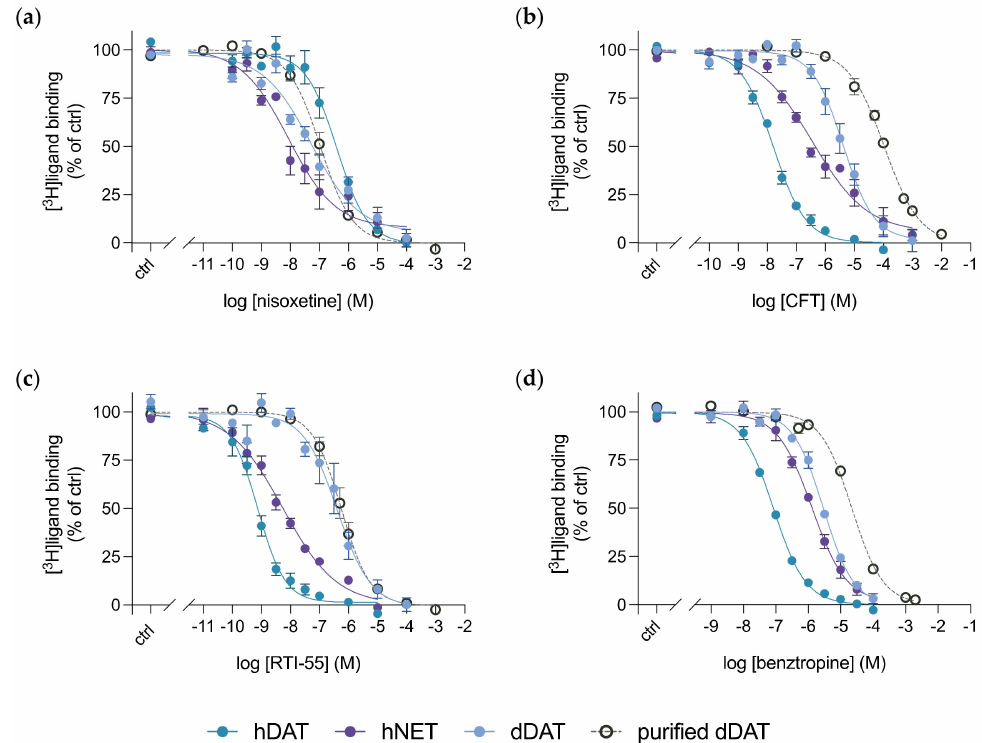
Figure 5. Competitive inhibition of radioligand binding to monoamine transporters in COS-7 cells or purified dDAT by ( a ) nisoxetine, ( b ) CFT, ( c ) RTI-55 and ( d ) benztropine. dDAT (blue filled circles), hDAT (green filled circles) and hNET (purple filled circles) were transiently transfected into COS-7 cells and underwent competitive radioligand binding. Purified dDAT (grey empty circles) also underwent competitive radioligand binding assays using SPA. [ 3 H]nisoxetine was used in the radioligand assays for both dDAT and hNET, and [ 3 H]CFT was used in the radioligand assays for hDAT. The K i values determined from these assays can be found in Table 1. All data points represent mean ± SEM, n = 3–4 from independent transfections of COS-7 cells and n = 3 from at least 2 independent dDAT purifications performed in triplicates. ctrl (control): [ 3 H]ligand binding in the absence of the competitive